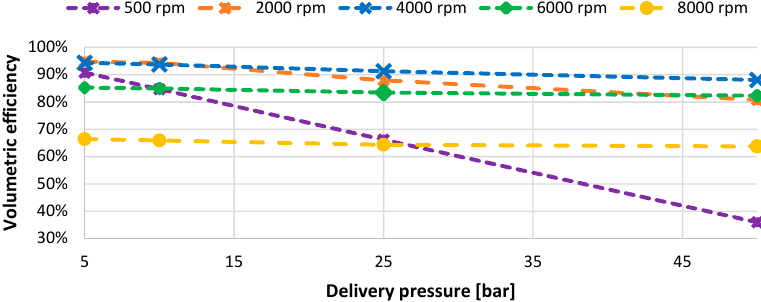
Figure 20. Dependence of the volumetric efficiency on the delivery pressure for different rotational speeds.